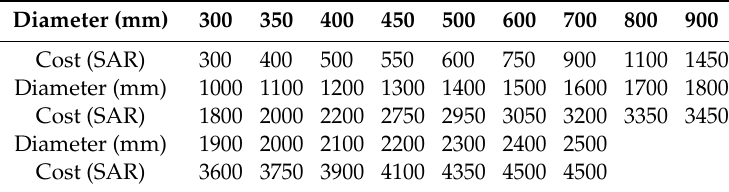
Table 2. Cost of supply and installation of di ff erent pipe diameters